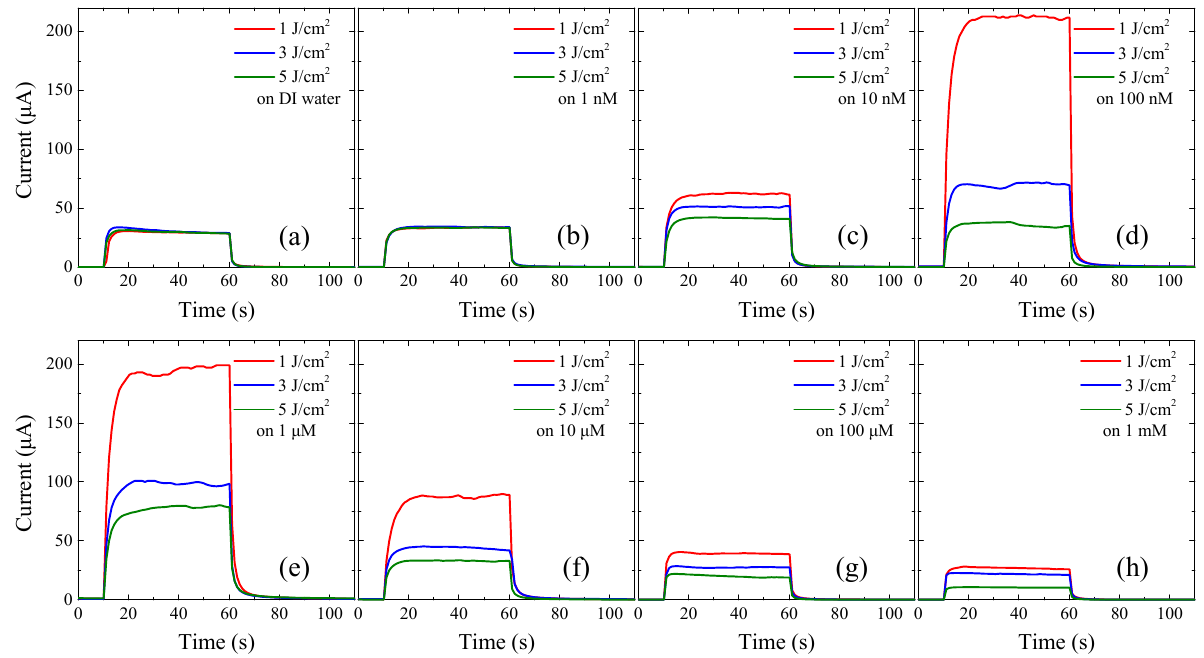
Figure 7. Photocurrent in UV PDs empolying the bare and Ag-decorated ZnO NWs processed in ( a ) DI water and AgNO3 concentration of ( b ) 1 nM, ( c ) 10 nM, ( d ) 100 nM, ( e ) 1 μ M, ( f ) 10 μ M, ( g ) 100 μ M, and ( h ) 1 mM.